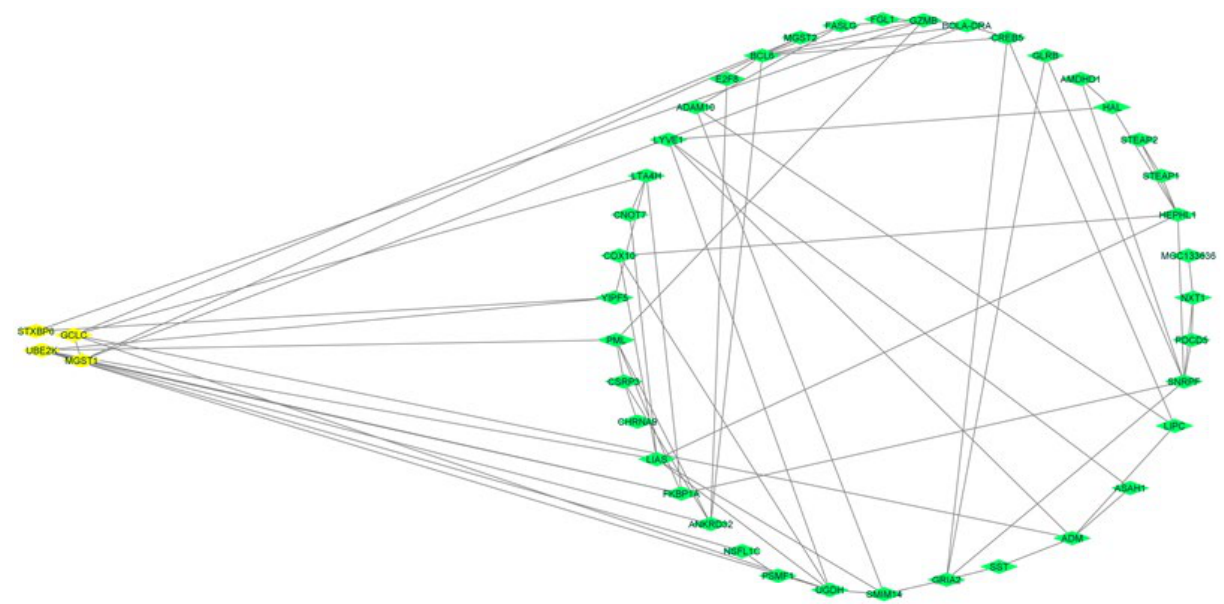
Figure 6. Gene network analysis for genes associated with udder structure traits in Holstein cow. (The yellow nodes represent the significant candidate genes and their interaction with related genes).